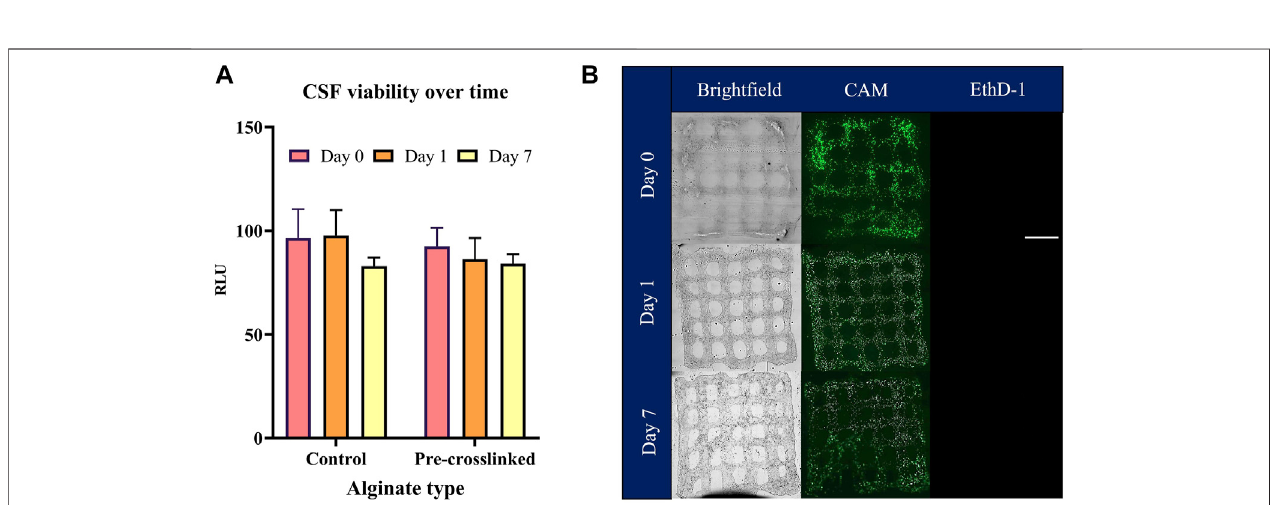
FIGURE 7 | Evaluation of CSF viability in pre-crosslinked alginate bio-inks. Cell-laden bio-inks were bio-printed prior to being assessed for metabolic activity (CSF viability) by CellTiterGlo. CELLINK bio-ink was used as a positive control (A) . Encapsulated cells were assessed for viability with CAM (live stain) and Ethd-1 (dead stain) and imaged (B) . Values are expressed as mean ± SD from three separate